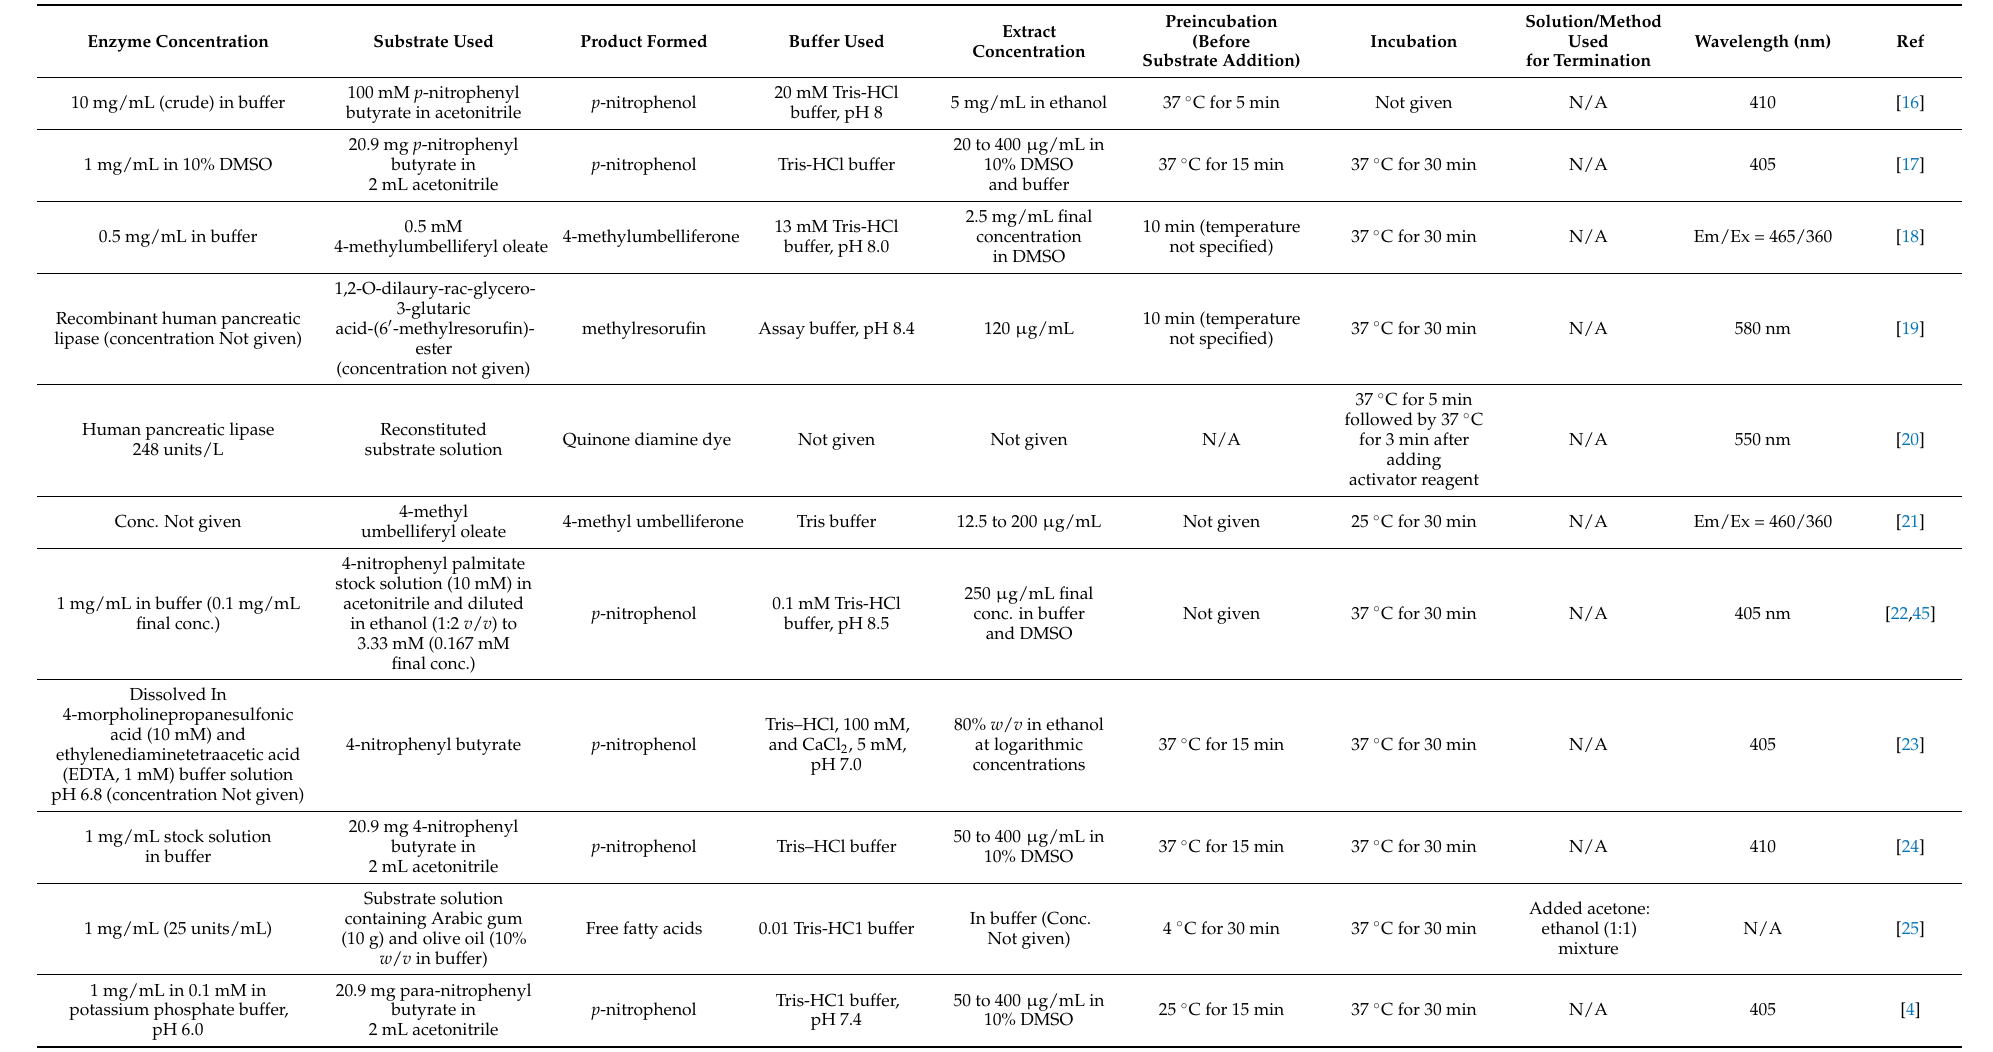
Table 2. Conditions used during the screening for pancreatic lipase inhibitors using plant